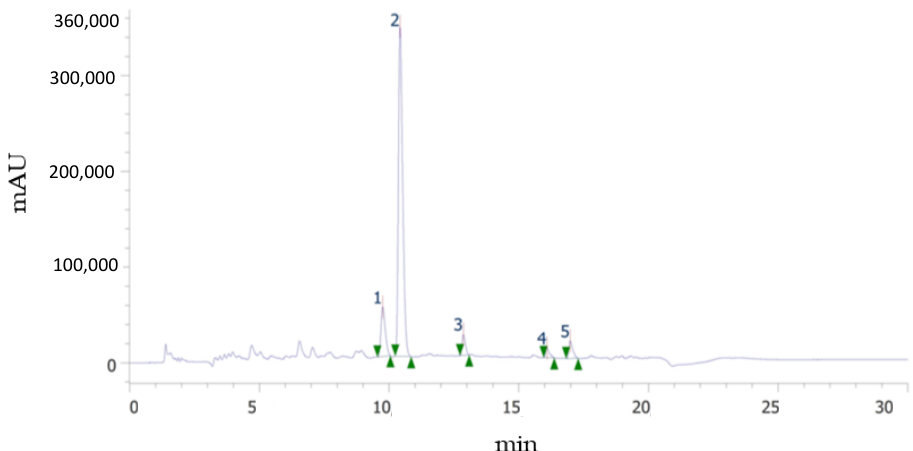
Figure 3. Example of chromatogram showing the flavonoid profile of the sample. (1) Narirutin. (2) Hesperidin. (3) Didymin. (4) Sinensetin. (5) Nobiletin.